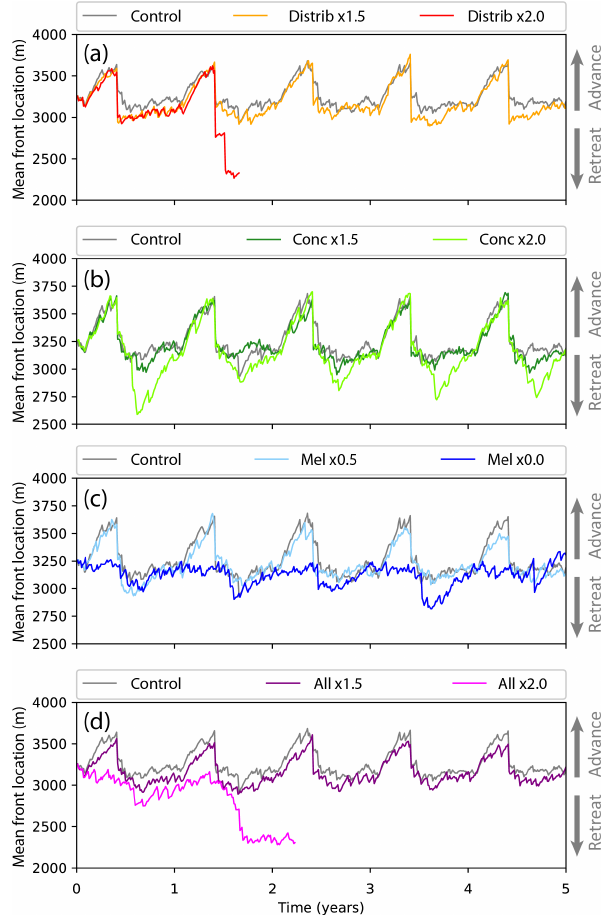
Figure 4. Mean terminus position over 5 years for step changes in (a) distributed melt rate (MD1, 2), (b) concentrated melt rate (MC1, 2), (c) mélange thickness (MM1, 2) and (d) all of the above (MA1, 2). Note the different y axis scales. X axis tick marks rep- resent 1 January. Runs MD2 and MA2 undergo rapid retreat before simulation breakdown (Sect.